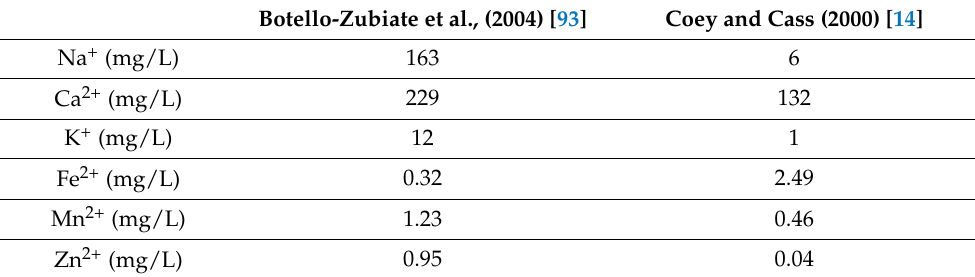
Table 5. Comparative analysis of the waters used in the studies (own elaboration).